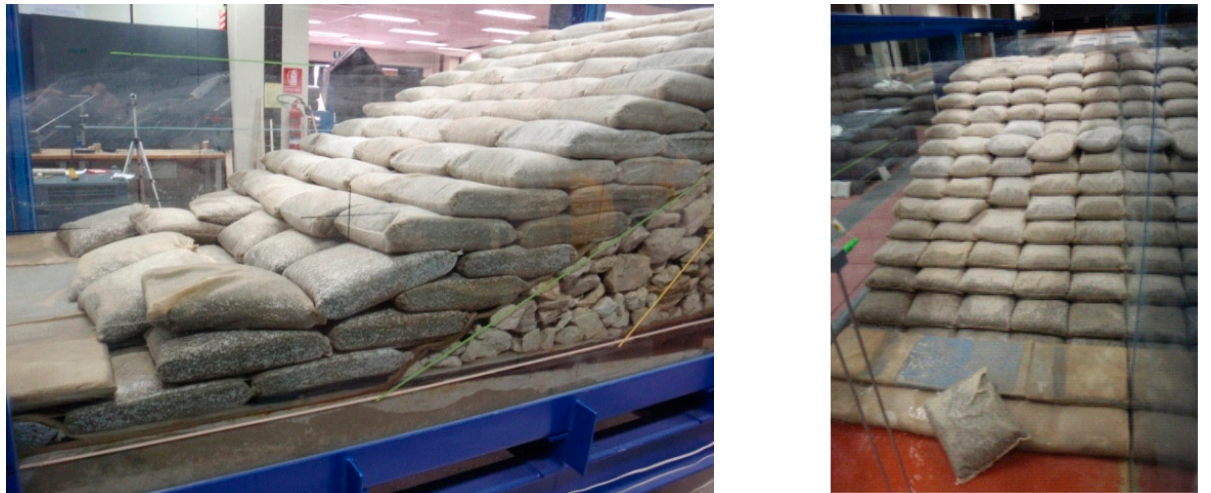
Figure 19. Configuration with slope 1:1.5. Uplift and movement of some elements in the stability test with H = 0.20 m, T = 1.5 s and h = 0.40 m.